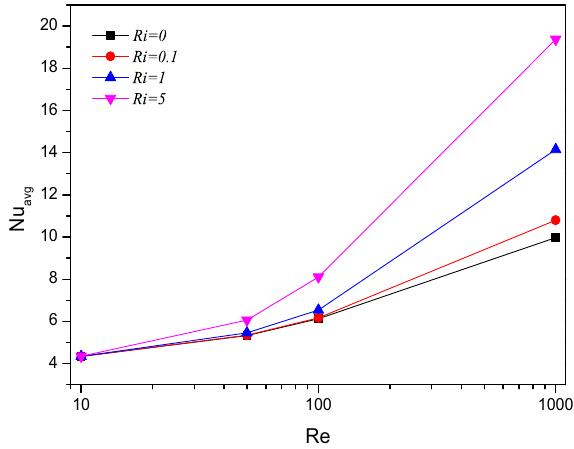
Figure 5. Variations of Nu avg with various Re for Ri variations, Re = 1000 , ϕ = 0.02 .